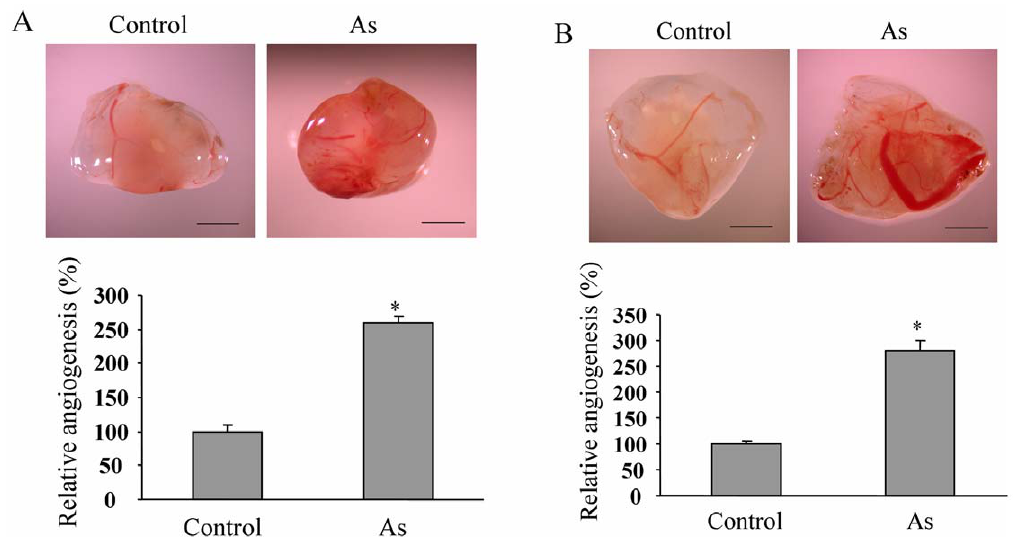
Figure 1. Arsenic induced angiogenesis . (A) A549 cells were treated without or with 5 m M of arsenic (As) for 5 h, then trypsinized, resuspended in serum-free medium (3 6 10 7 cells/ml, 0.1 ml), and mixed in 1:1 ratio with Matrigel (Collaborative Biomedical Products, Bedford, MA). Aliquots of the mixture were then implanted onto the CAM of 9-day-old embryos. After 96 h incubation, the area around the implanted Matrigel was photographed with a Nikon digital camera. Bar: 2 mm (upper panel). The number of blood vessels was obtained by counting the branching of blood vessels, and the relative angiogenesis was obtained by normalizing to that of the control without arsenic treatment. The data represent the mean 6 SD of the relative angiogenesis from eight different embryos (bottom panel). *, indicates that the relative angiogenesis index significantly increased in arsenic treatment group when compared with control group, P , 0.05. (B) BEAS-2B cells were treated with or without arsenic to perform tumor angiogenesis assay as above. Bar: 2 mm. *, indicates that the relative angiogenesis index significantly increased in arsenic treatment group when compared with control group, P , 0.05.